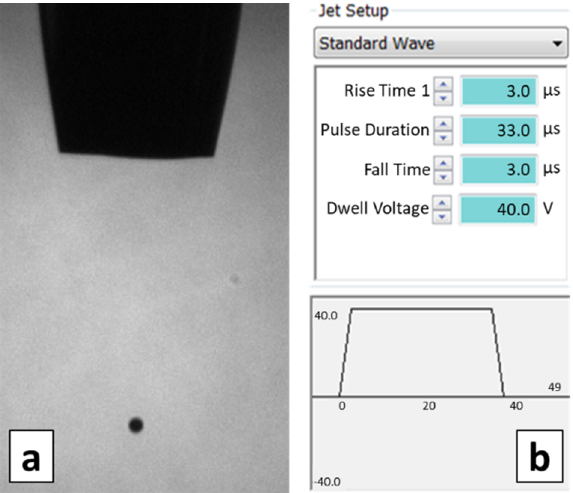
Figure 3. ( a ) Stable drop; ( b ) Voltage waveform. Table 1. Experimental design summary. Factor Symbol